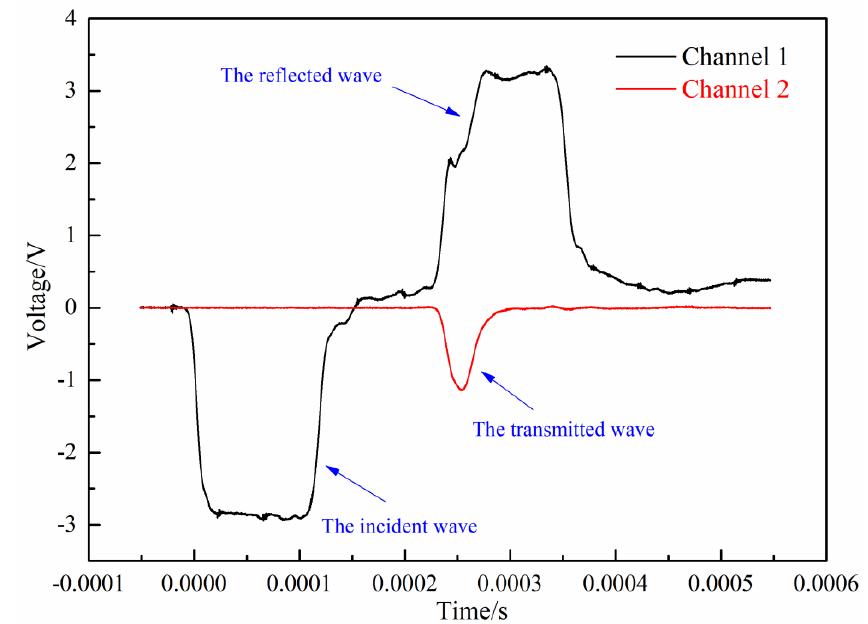
Figure 6. Typical signals on the incident and transmission bars for 210 cyclic hygrothermal aging days